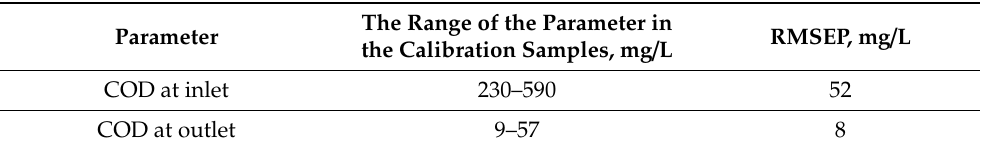
Table 5. The values of RMSEP for the determination of COD by the multisensor system employing two separate concentration ranges.